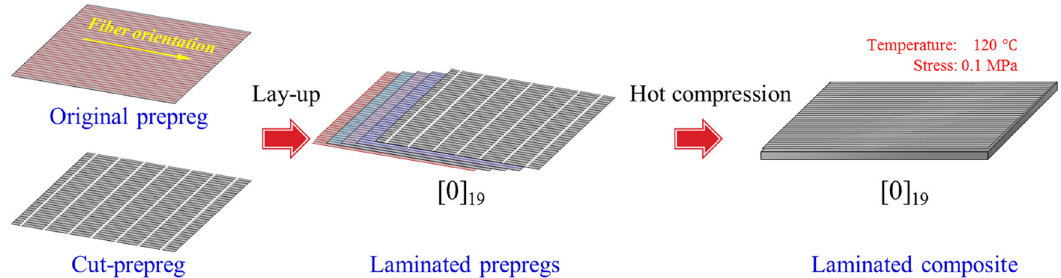
Figure 1: Schematic of CF/epoxy laminates with fiber